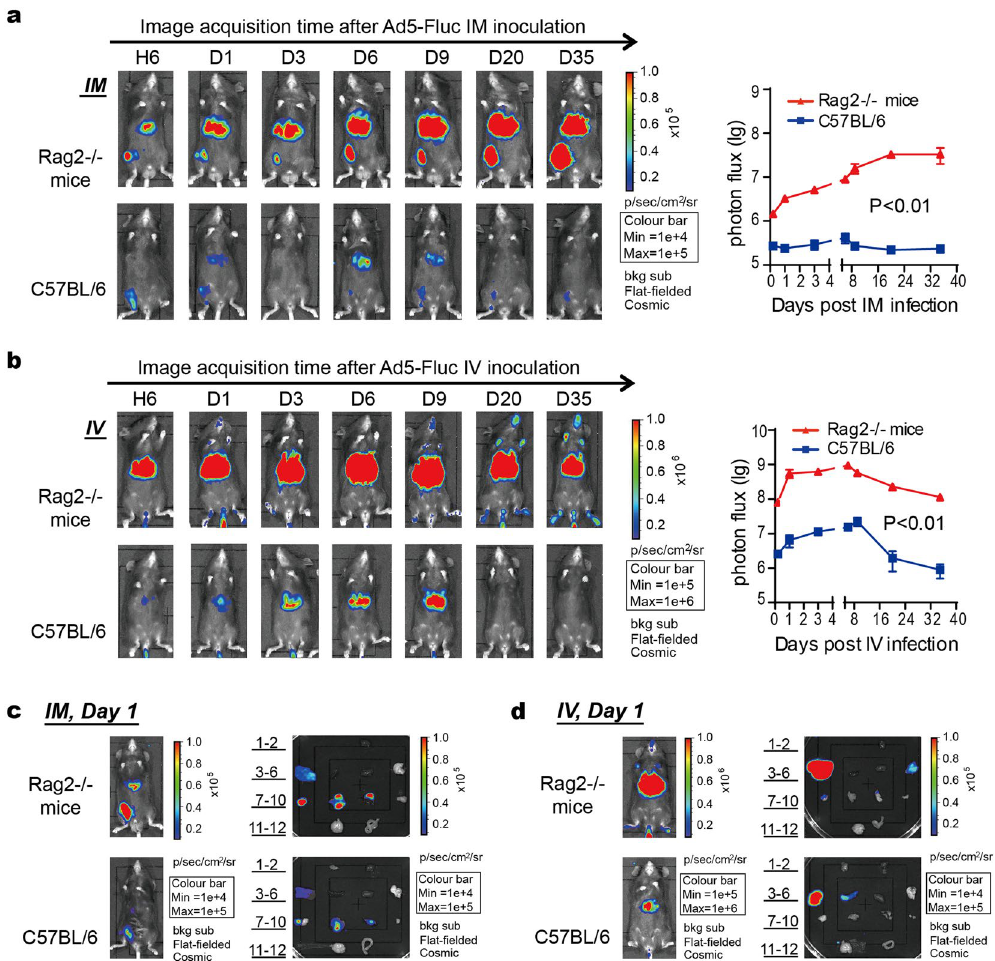
Figure 1. In vivo imaging of luciferase expression after inoculation of wildtype C57BL/6 and immunodeficient Rag2 − / − mice with Ad5-Fluc. ( a , b ) Four-week-old Rag2 − / − and C57BL/6 mice (n = 10/group) were inoculated with 5 × 10 10 pfu/kg Adv5 by the IM ( a ) or IV route ( b ). Bioluminescent images of a representative mouse from each group are shown at 6 h, 1 day, 3 days, 6 days, 9 days, 20 days, and 35 days post-infection. Relative bioluminescence intensity is shown in pseudo-colour, with red and blue representing the strongest and weakest photon fluxes, respectively. Mean ( ± standard error of the mean) values for total flux at different time points are shown. The differences between subgroups were calculated with a paired t -test. ( c , d ) Rag2 − / − and C57BL/6 mice inoculated with Ad5-Fluc by the IM route ( c ) or IV route ( d ) were imaged on day 1 post-inoculation. Different organs were dissected and tested for Fluc transgene expression with BLI: (1) thymus, (2) heart, (3) liver, (4) spleen, (5) kidney, (6) lung, (7) lymph node, (8) muscle, (9) skin, (10) ovary/testis, (11) brain, and (12)